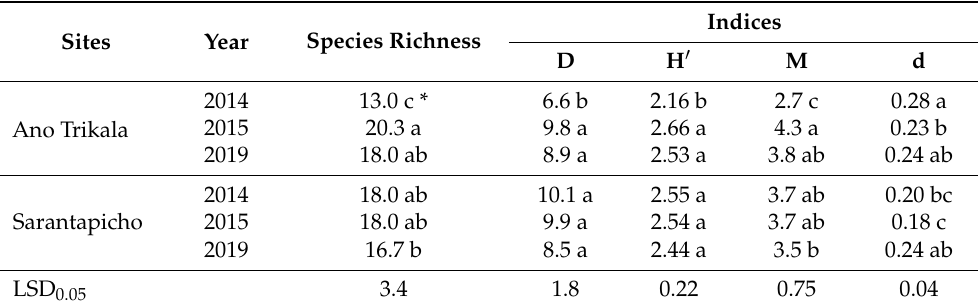
Table 5. Effects of site and year on the Species richness, Simpson (D), Shannon (H (cid:48) ), Margalef (M), and the Berger–Parker (d) dominance index.